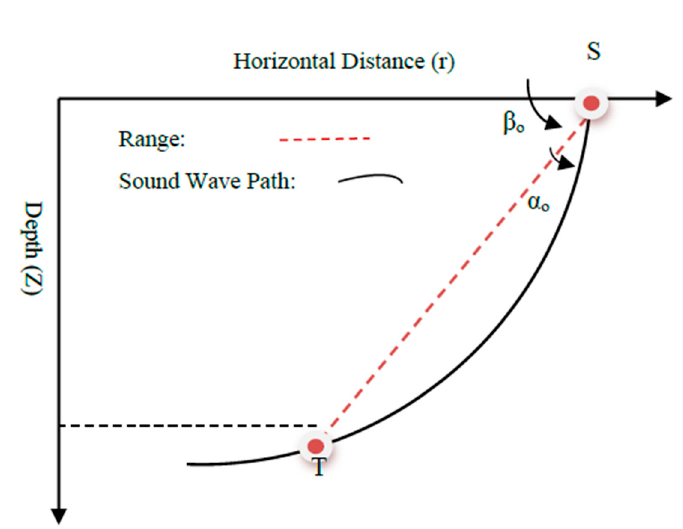
Figure 2. Curved path followed by the sound wave from the sensor to the target autonomous underwater vehicle (AUV).